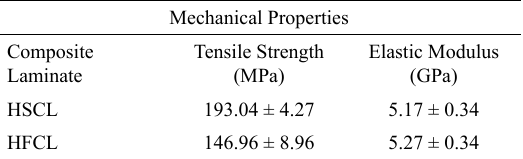
Table 2. Mechanical properties - laminates HSCL and HFCL - uniaxial tensile.